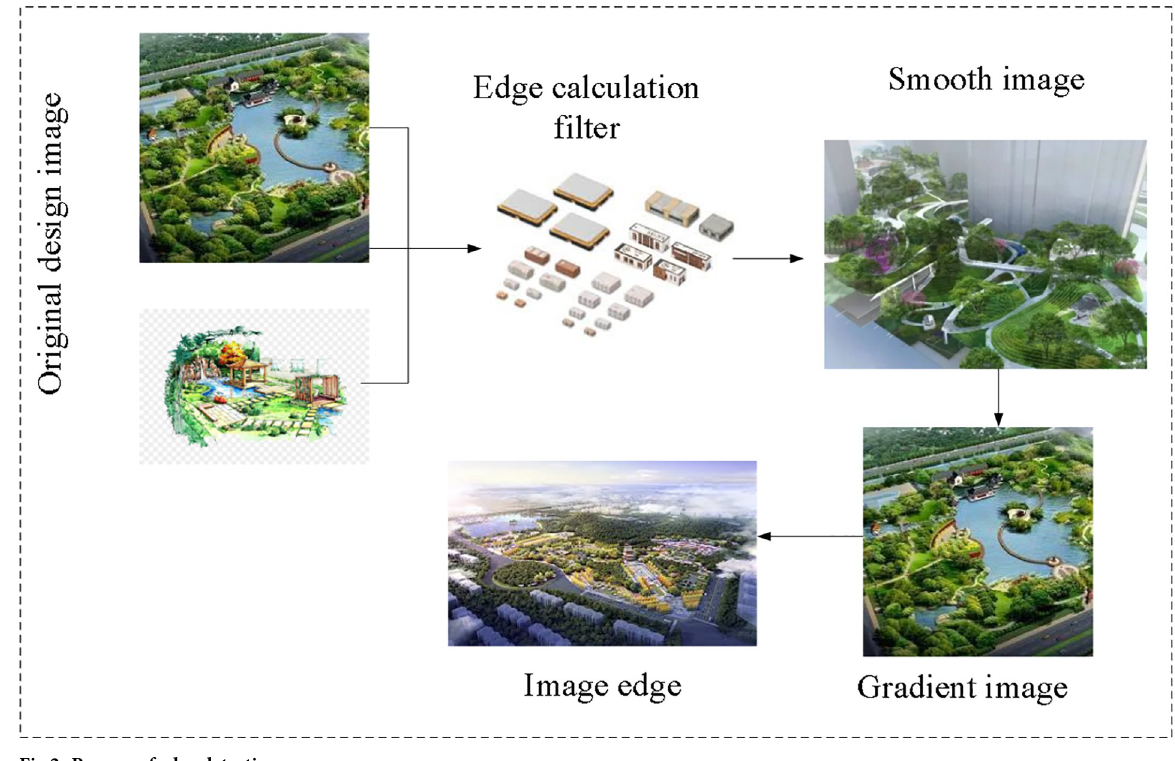
Fig 2. Process of edge detection.